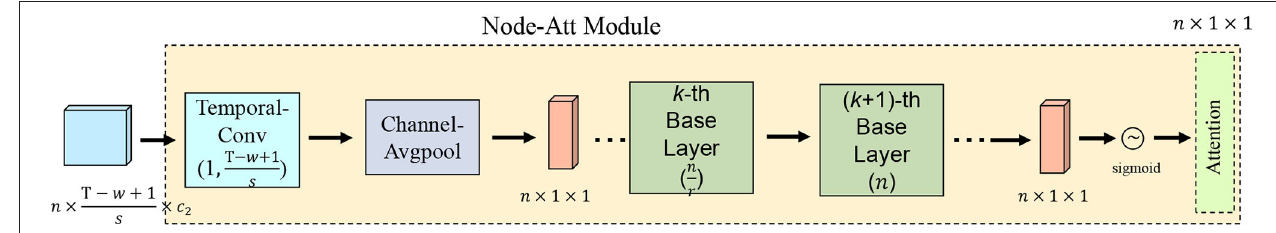
FIGURE 3 | Illustration of attention mechanism. Temporal-Conv represents temporal convolution operation, Channel-AvgPool represents channel average pooling operation, and r represents the down-sampling rate.